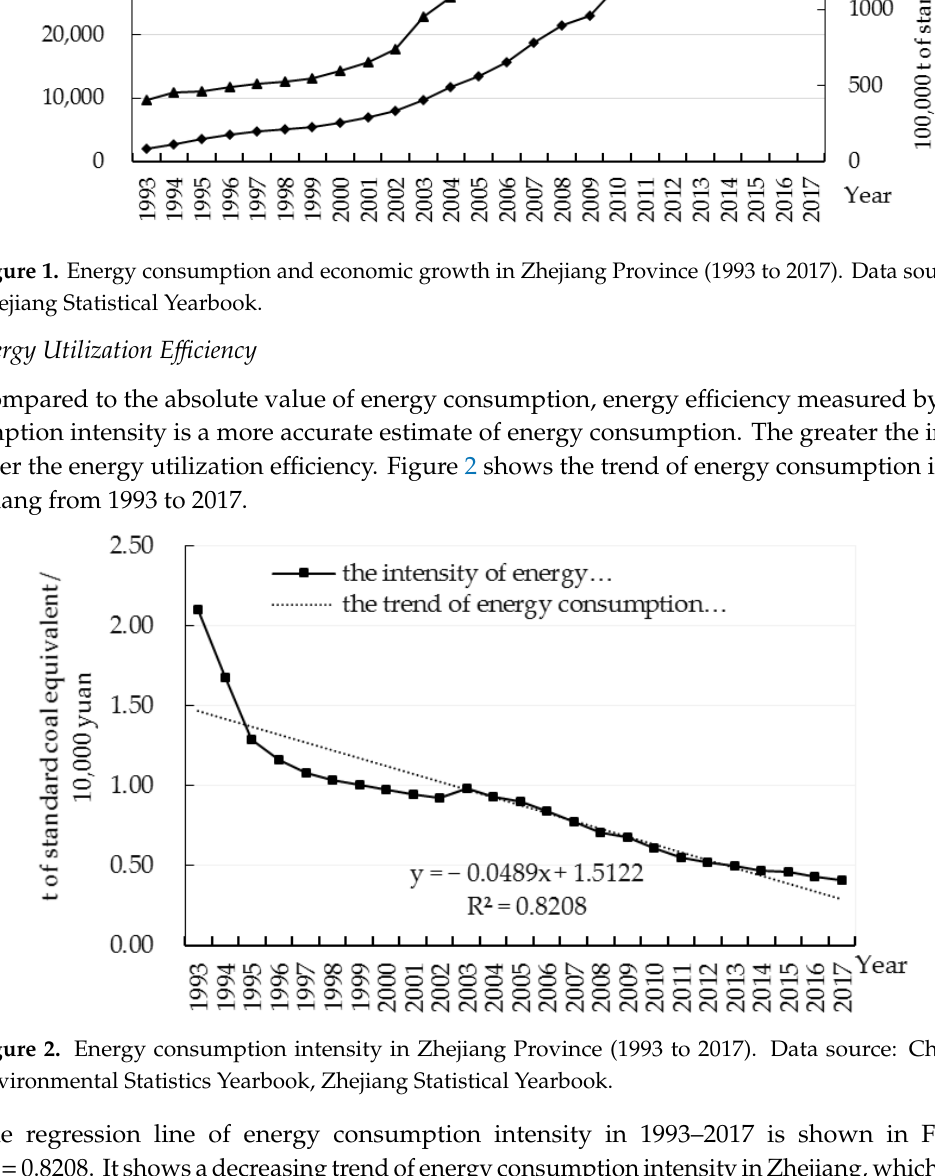
Figure 1. Energy consumption and economic growth in Zhejiang Province (1993 to 2017). Data source: Zhejiang Statistical Yearbook.